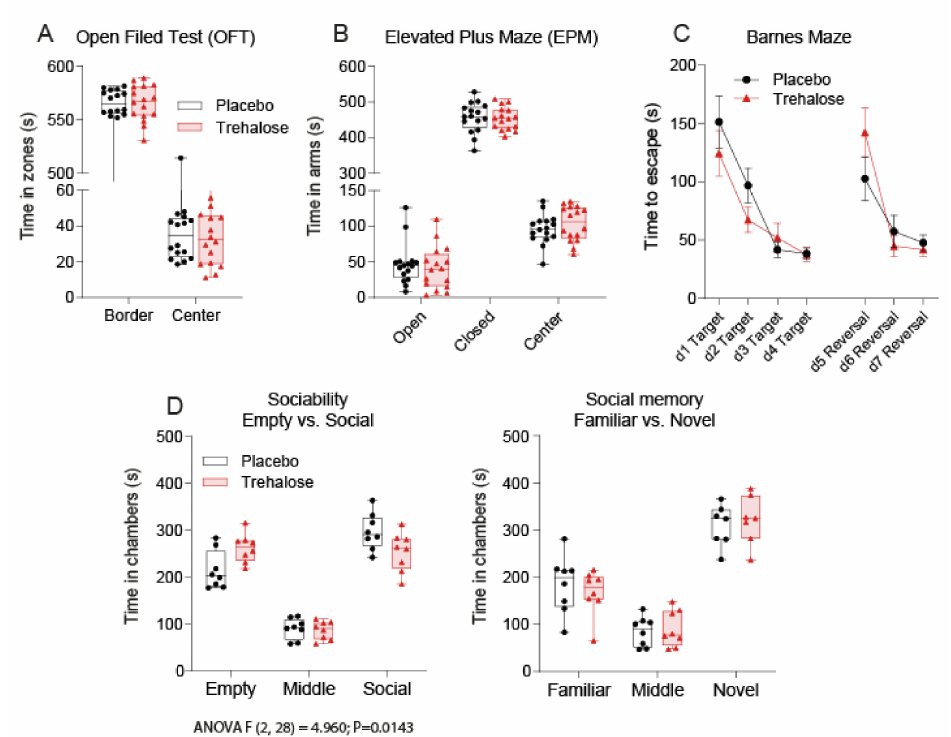
Figure 7. Behavior in Open Field, Elevated Plus Maze, Barnes Maze, and sociability and social memory tests. ( A ): Times spent in the center and border zones in OFT (7 weeks after SNI). ( B ): Times spent in the open and closed arms and in the center area in EPM test (7 weeks after SNI). ( C ): Time needed to escape in the shelter box in a Barnes Maze (8–11 weeks after SNI) in four learning trials (d1–d4) and three reversal learning trials (d5–d7). Data are means and SD. ( D ): Time spent in the compartments in a three-chamber maze test of sociability and social memory (40 weeks after SNI). The first part (Sociability) shows the preference of a social partner over an empty compartment. The second part (Social Memory) shows the preference of a novel social partner over the familiar mouse. The box is the interquartile range, the line the median, the whiskers minimum to maximum, the scatters show individual mice ( n = 8 per group). OFT and EPM were done twice, hence each mouse is represented by two dots. Data were compared with 2-way ANOVA. OFT, EPM and Barnes were did not differ between